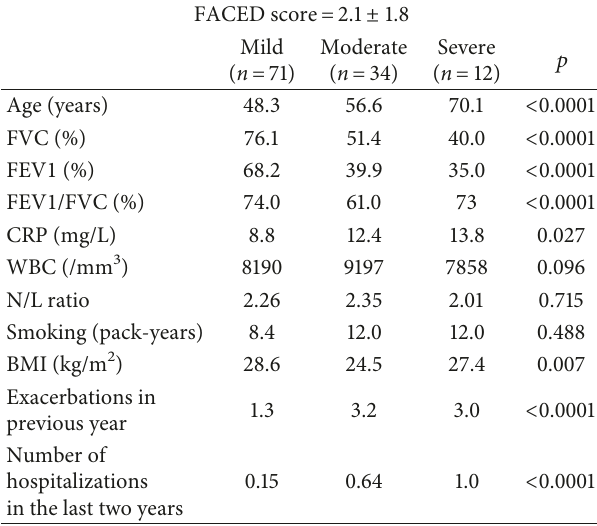
Table 3: The relation between bronchiectasis severity based on FACED score and the other study